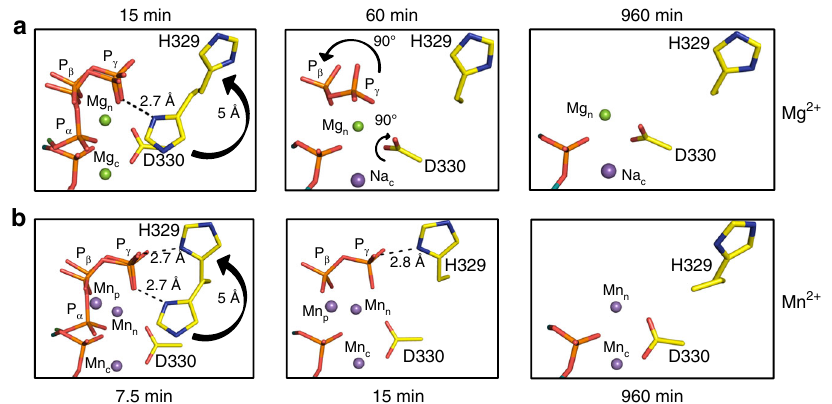
Fig. 4 Active site conformational adjustments during single-nucleotide gap- fi lling by pol μ . a Mg 2+ -mediated insertion, and b Mn 2+ -mediated insertion. Black arrows indicate movement compared to the previous panel from left to